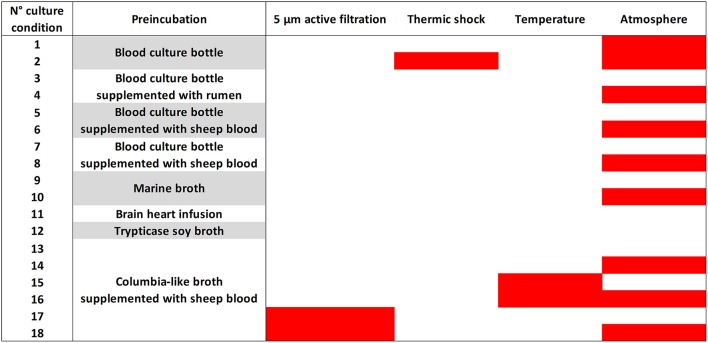
The 18 culture conditions of standardized culturomics. The 18 culture conditions are here represented according to the preincubation liquid medium, mode of treatment of the stool sample, temperature, and atmosphere. The red bars represent in the third column an active filtration (5 μm) applied to the stool sample, in the fourth column a thermal shock (80°C during 20 min) applied to the stool sample, in the fifth column a 28°C incubation temperature and in the sixth column an anaerobic atmosphere of incubation. No coloration represents in the third column no active filtration applied to the stool sample, in the fourth column no thermal shock applied to the stool sample, in the fifth column a 37°C incubation temperature and in the sixth column an aerobic atmosphere of incubation.